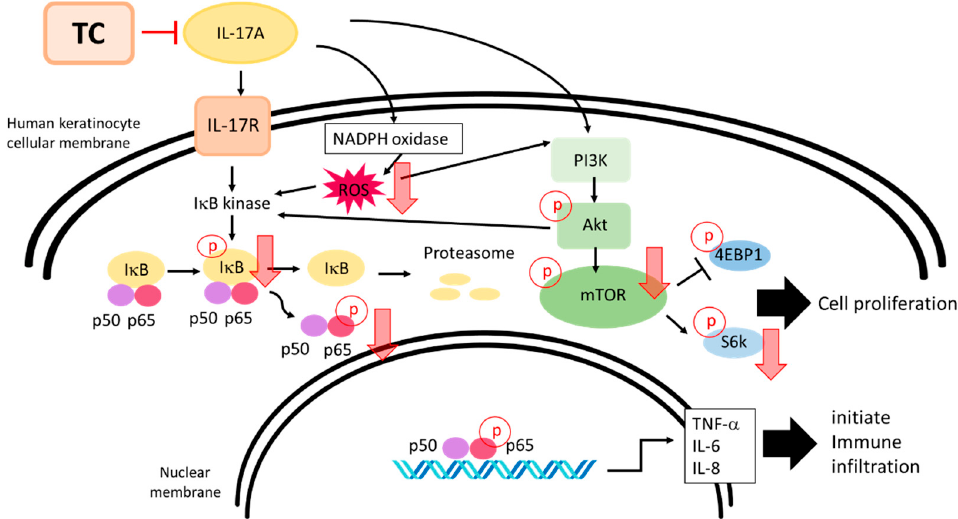
Figure 12. Schematic diagram illustrating the inhibitory effects of TC on IL-17A-induced inflam- mation and proliferation in human keratinocytes.